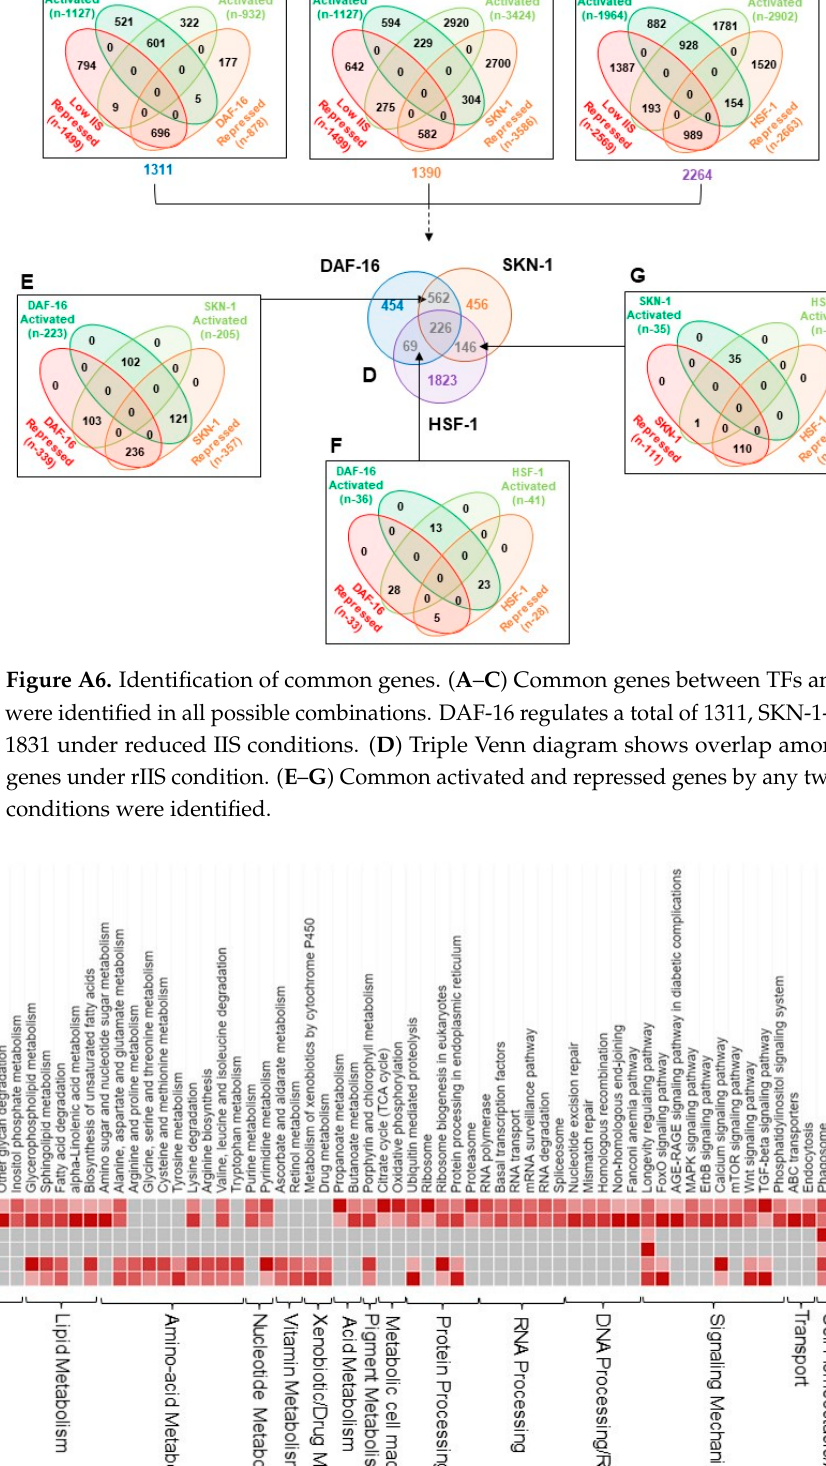
Figure A5. Gene expression profiles of rIIS associated TFs. ( A ) Venn diagram of TF-dependent repressed and activated genes. ( B ) Venn diagram of TF-dependent repressed and activated genes under reduced IIS condition. ( C ) A total of 9034 differentially expressed non-redundant genes regulated by all three TFs. ( D ) A total of 3297 non-redundant differentially expressed genes regulated by all three TFs under rIIS conditions.